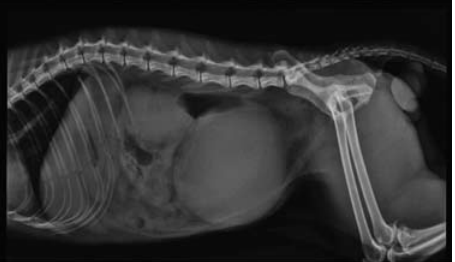
Fig. 2 . Distended bladder on lateral survey